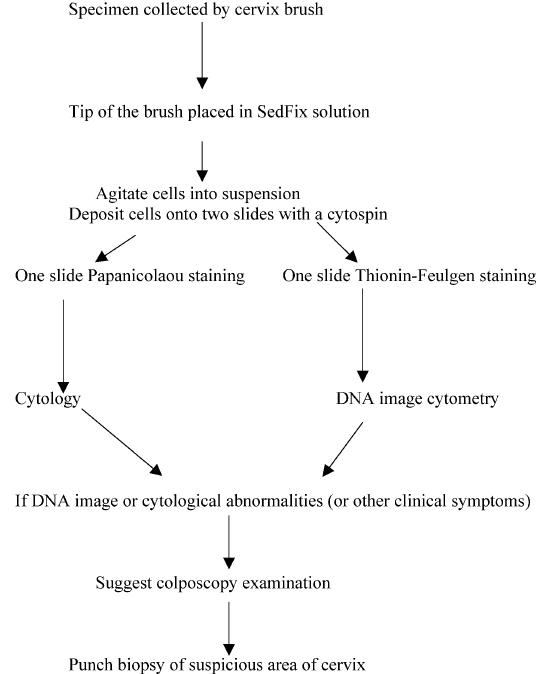
Fig. 1. Experimental protocol. Protocol used to prepare two sister slides for manual cytology and DNA assisted cytology from the same specimen and to select subjects for